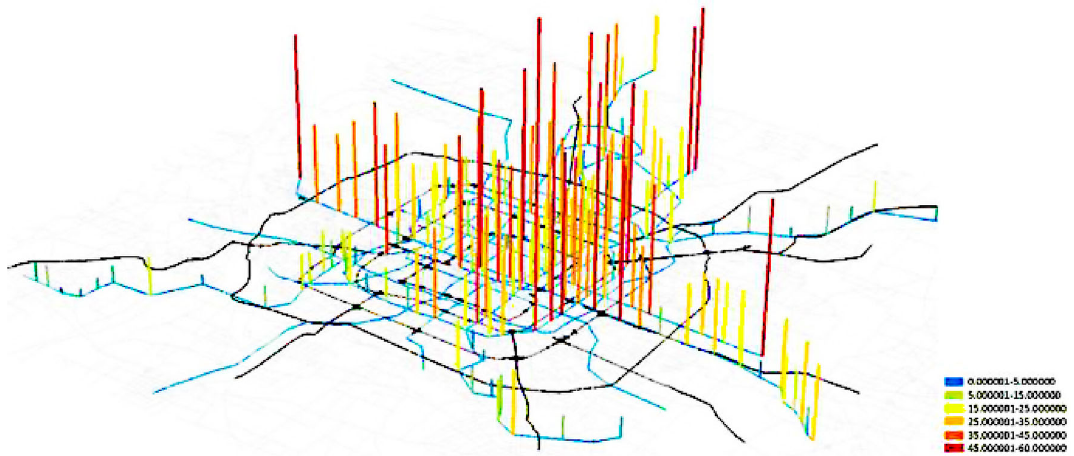
Fig. 6 Passenger volume of urban metro station in